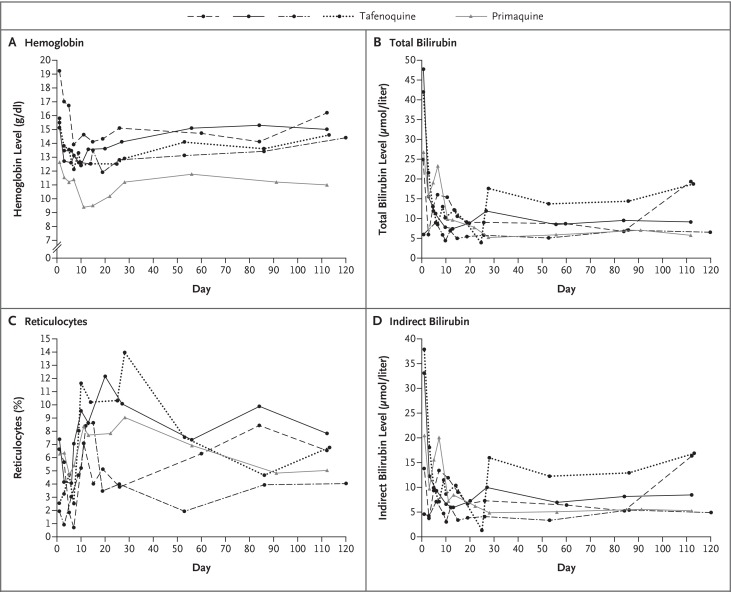
Changes in Key Hematologic Measures among Individual Patients Who Met the Primary Safety Outcome of a Protocol-Defined Decrease in the Hemoglobin Level in the GATHER Trial (Safety Population).A protocol-defined decrease in the hemoglobin level (>3.0 g per deciliter or ≥30% from baseline or to a level of <6.0 g per deciliter) occurred in 4 of 166 patients in the tafenoquine group and in 1 of 85 patients in the primaquine group. To convert bilirubin to milligrams per deciliter, divide by 17.1.